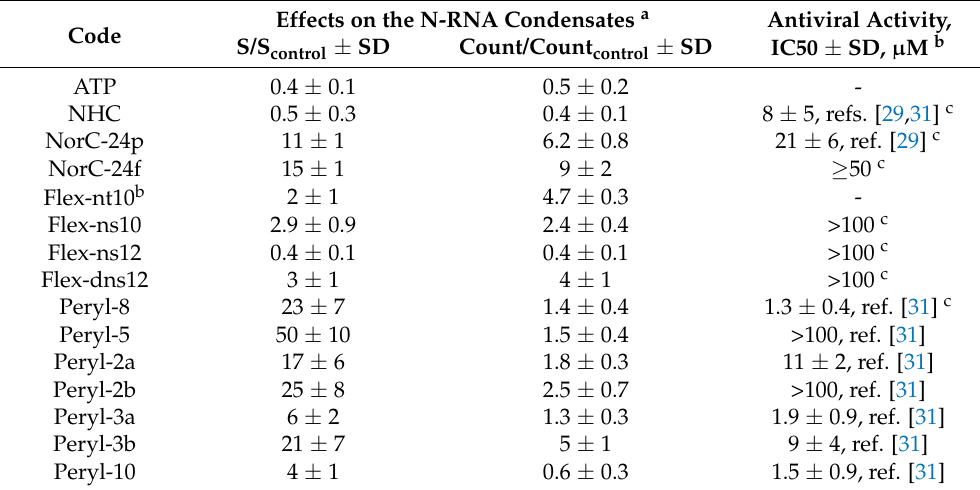
Table 1. LLPS modulation assays with known small-molecule antiviral agents and their